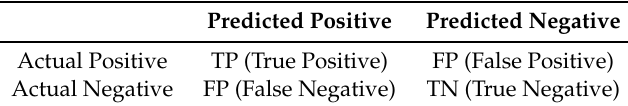
Table 3. Confusion matrix for two